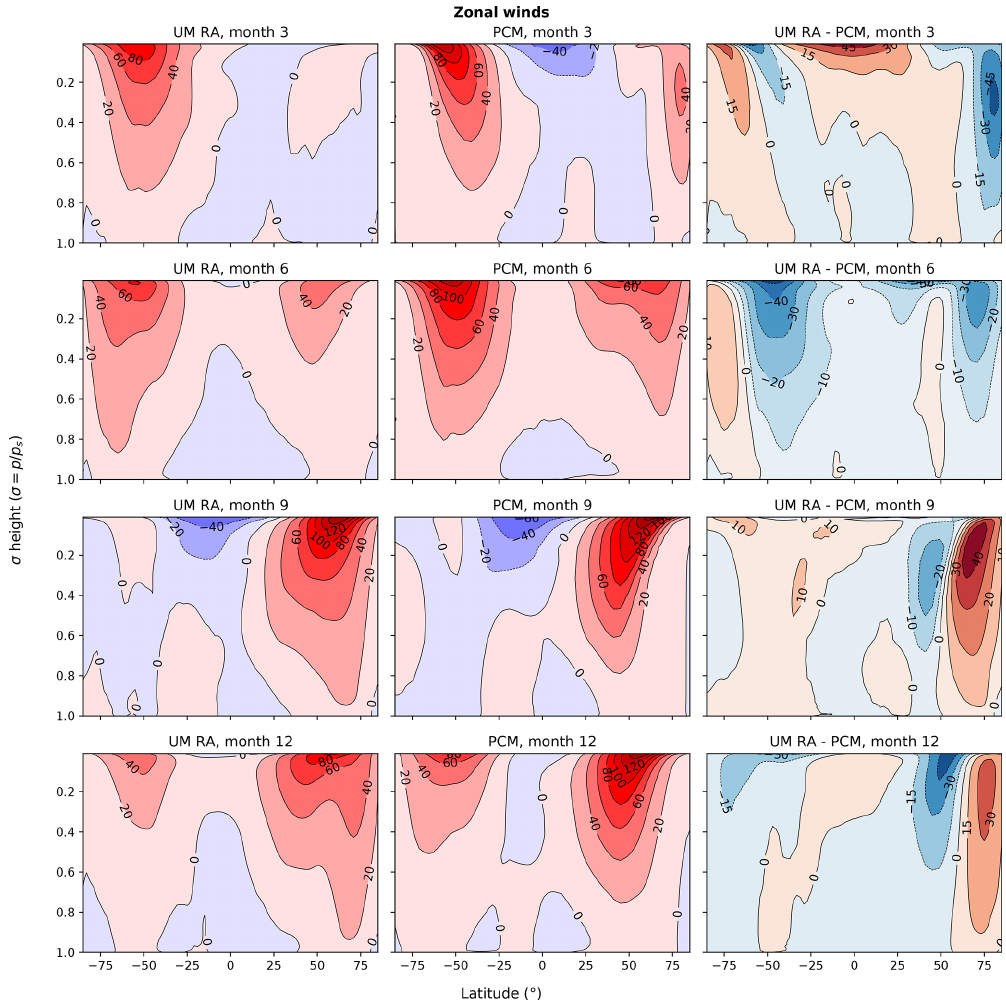
Figure A6. Zonal mean zonal winds (ms − 1 ) across four seasons within the Martian year. For each month, the time average is taken of all sols within that month. The RA dust scenario is shown on the left, the PCM output in the centre and the differences between models on the right. Colour scales in the left-hand and right-hand plots are matched across all months and between models, with contour intervals of 20ms − 1 . The contours in the difference plots are not matched due to the varying intensity of the difference between months. Positive values indicate a northward wind and negative values a southward